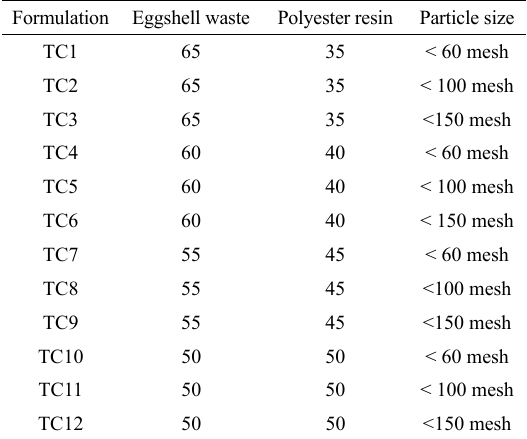
Table 1. Compositions of the artificial rocks (wt.%).